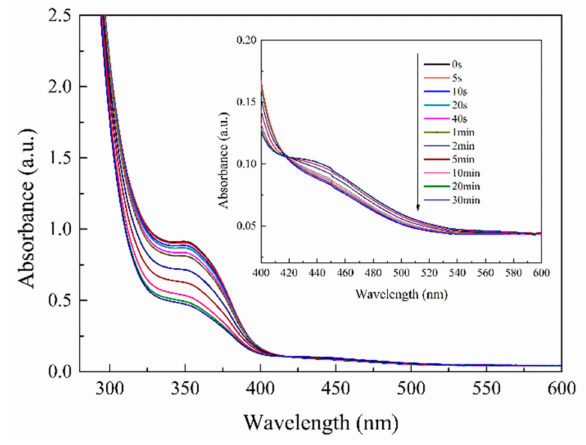
Figure 7. UV–Vis absorption changes of the composite films irradiated by UV light of 365 nm for different times from 0 s~30 min.